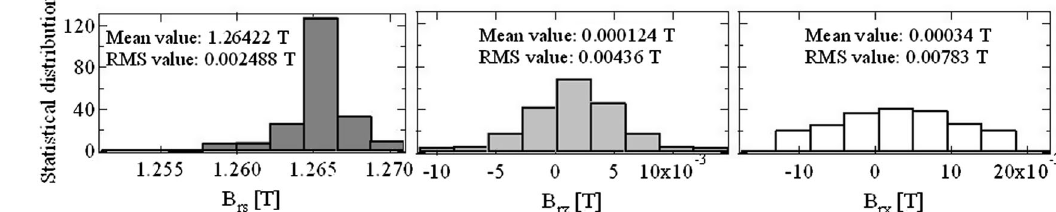
FIG. 7. Magnetization components, main B rs ( ) and parasitic B rz ( ), and B rx ( h ) measured with Helmholtz coil.